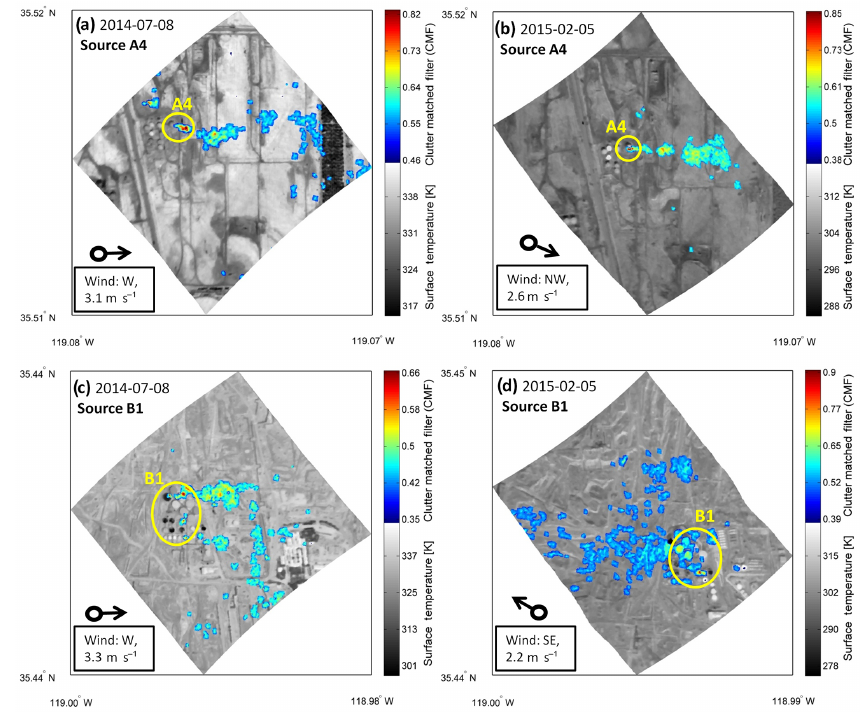
Figure 7. Examples of persistent methane plumes detected by HyTES over oil condensate storage tanks in the Kern Front and Kern River oil fields near Bakersfield, California. Sources A4 in panels (a) and (b) , and B1 in panels (c) and (d) were detected during July 2014 and February 2015. Plume enhancements are shown in color using the CMF method overlayed on a surface temperature